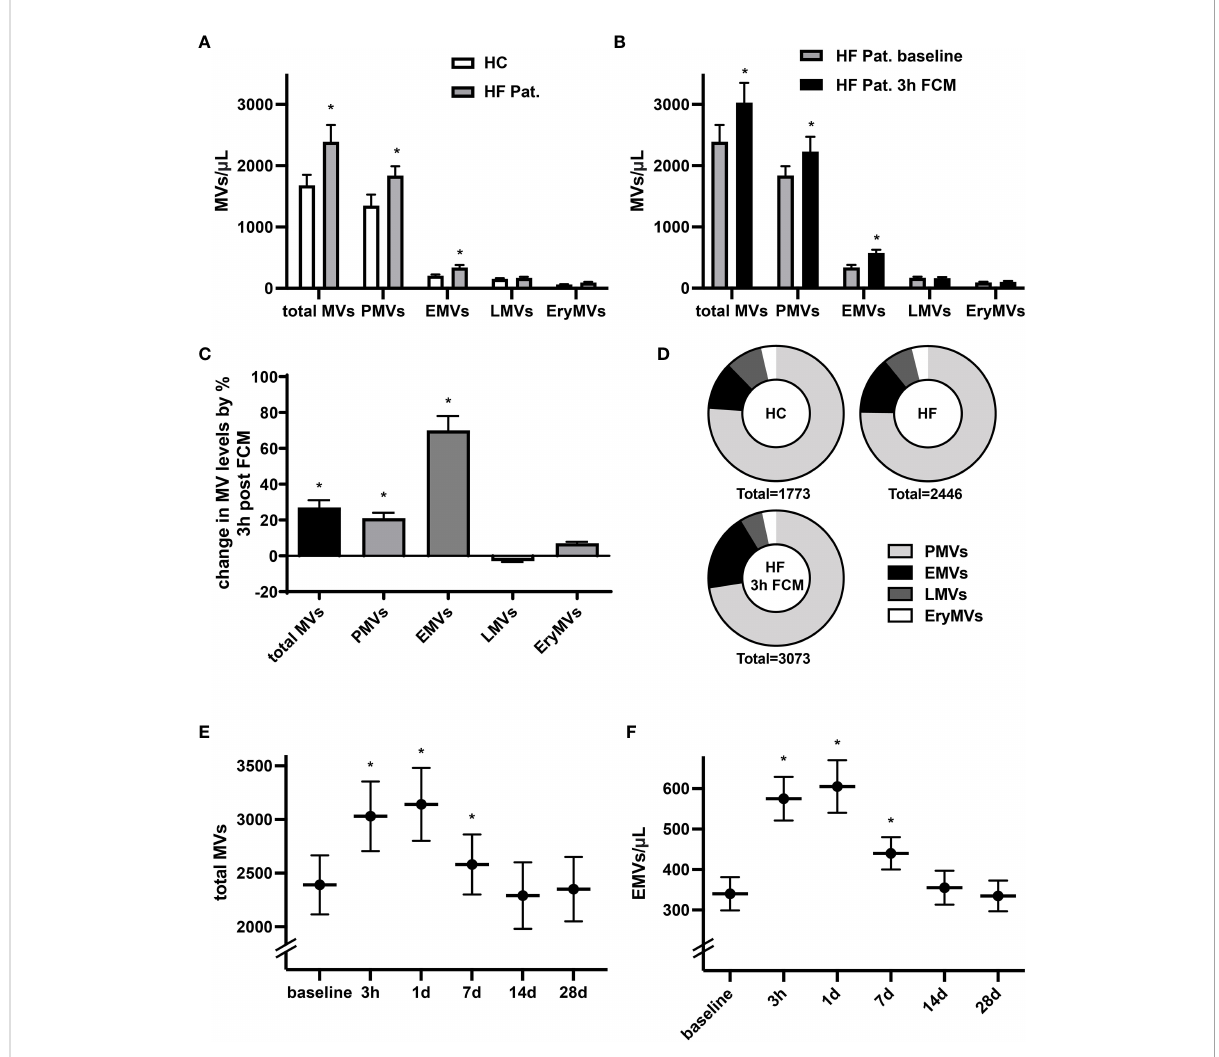
FIGURE 1 Administration of FCM in HF patients induces temporary increase in MV concentration. (A) Levels of circulating MVs and their subpopulations in HF patients with reduced LV-function and iron de fi ciency compared to healthy controls (HC). MVs and their phenotypic pro fi le